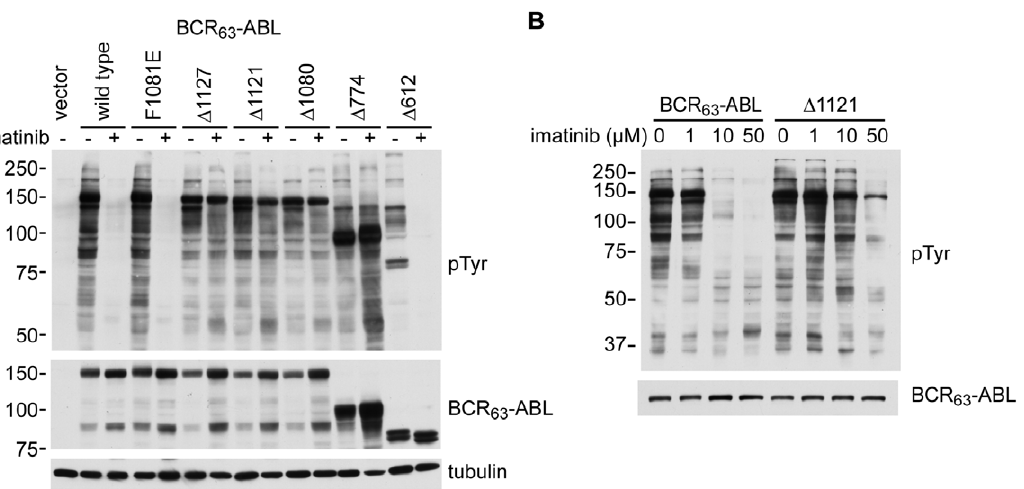
Figure 7. Kinase activity and imatinib-sensitivity of BCR 63 -ABL mutants. A and B : COS cells were transfected with BCR 63 -ABL or the indicated mutant constructs. The cells were left untreated or treated with 10 m M imatinib ( A ) or different doses of imatinib ( B ) for 16 hours to inhibit BCR-ABL kinase activity. Immunoblotting of whole cell lysates with an antibody (4G10) against phophostyrosine (pTyr) was used to indicate the levels of the BCR-ABL tyrosine kinase activity. The levels of the BCR 63 -ABL protein were determined by immunoblotting with an anti-ABL antibody (8E9). The levels of tubulin were shown as a loading control. The positions of the molecular weight markers (in kilodalton) are indicated at the left of the blot.